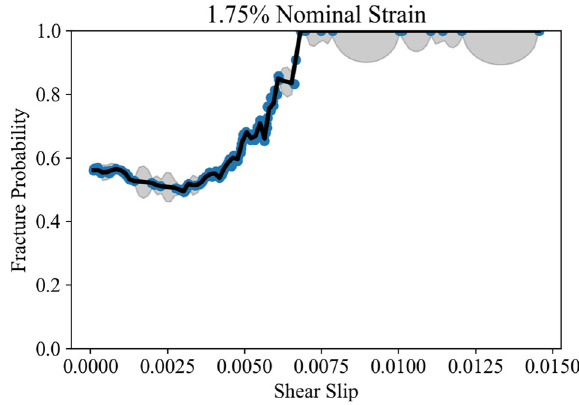
Fig. 13 Fitted GPR representing the failure probability for shear stress levels at 1.75% nominal strain.